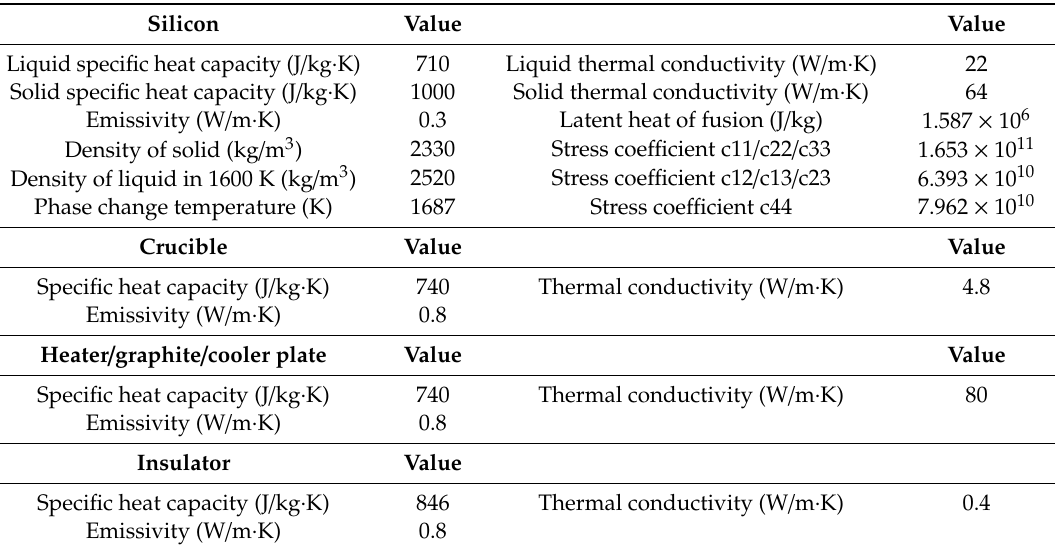
Figure 1. Two-dimensional representation of an axisymmetric directional solidification furnace for multicrystal Si and computational grids. Table 1. Material properties of the furnace.